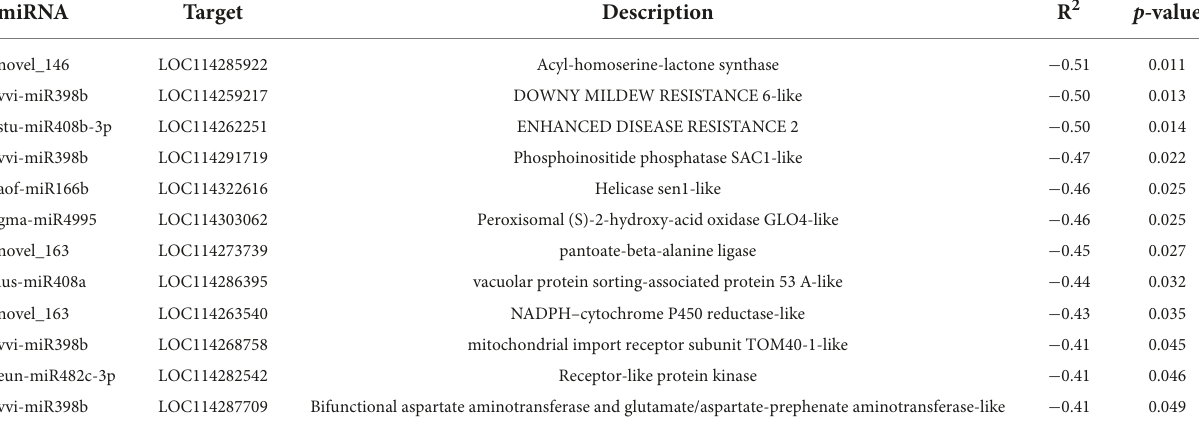
TABLE 2 miRNA-mRNA regulatory network response to drought stress in Camellia oleifera